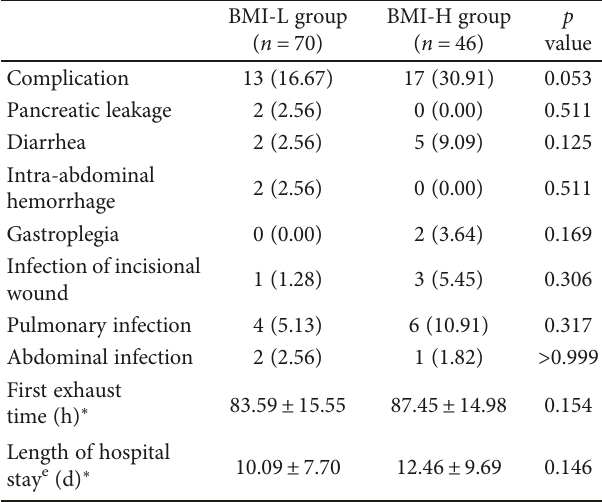
Table 7: Comparison of the postoperative outcomes between the low-BMI group and high-BMI group (cases